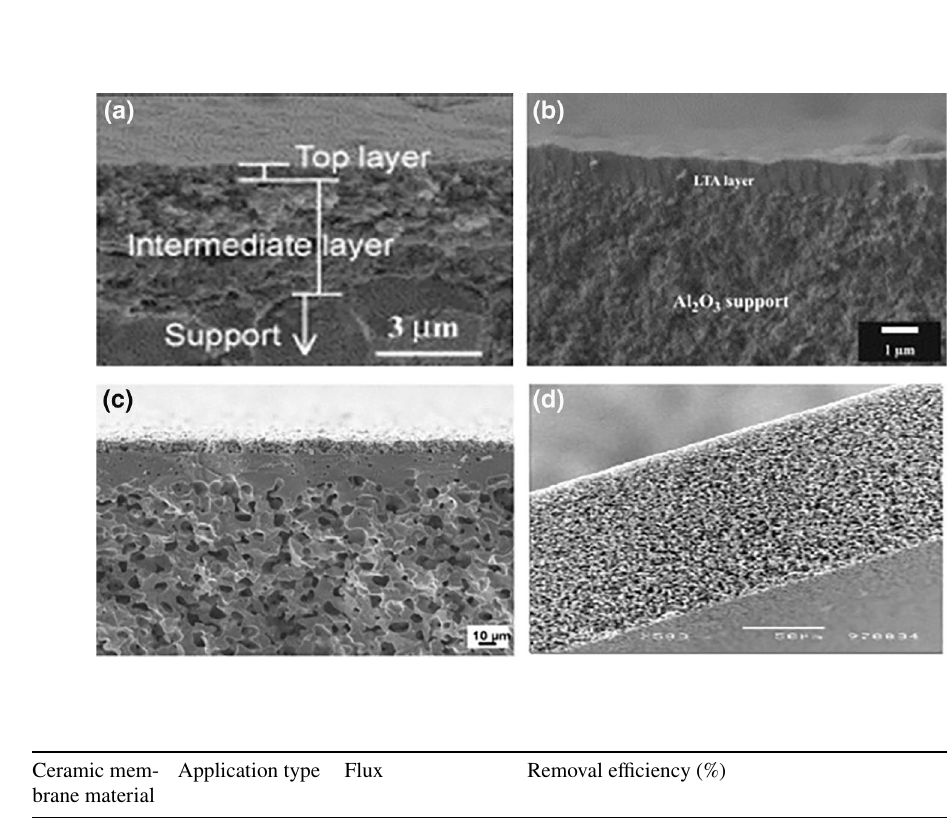
water (PW) treatment using various ceramic membranes (Kayvani Fard et al.